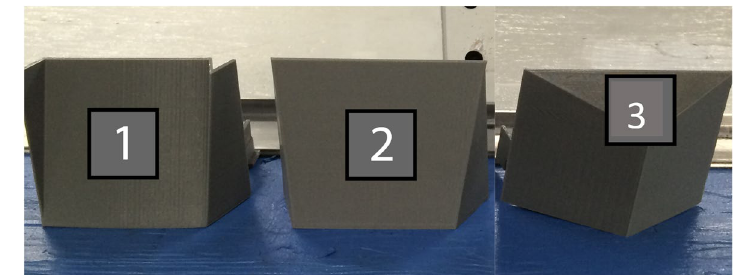
Fig. 11 Image of three fairings tested in the wind tunnel